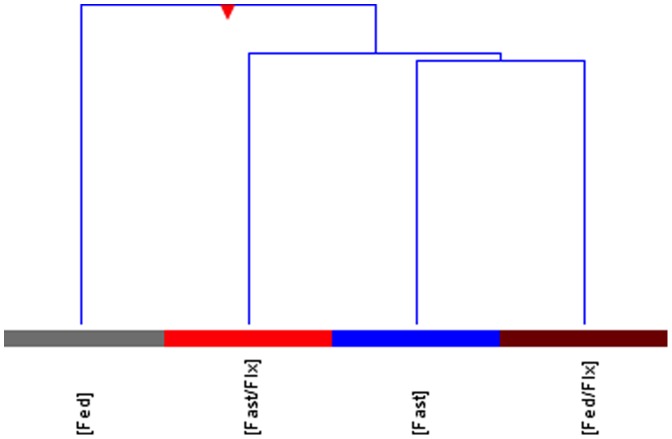
Cluster analysis demonstrating a significant relationship between individuals that were fasted and those exposed to fluoxetine versus those individuals who were only fed.[Fed]: Control; [Fast]: fasted only; [Fast/FLX]: fasted and exposed to 540 ng/L fluoxetine; [Fed/FLX]: fed and exposed to 540 ng/L fluoxetine.